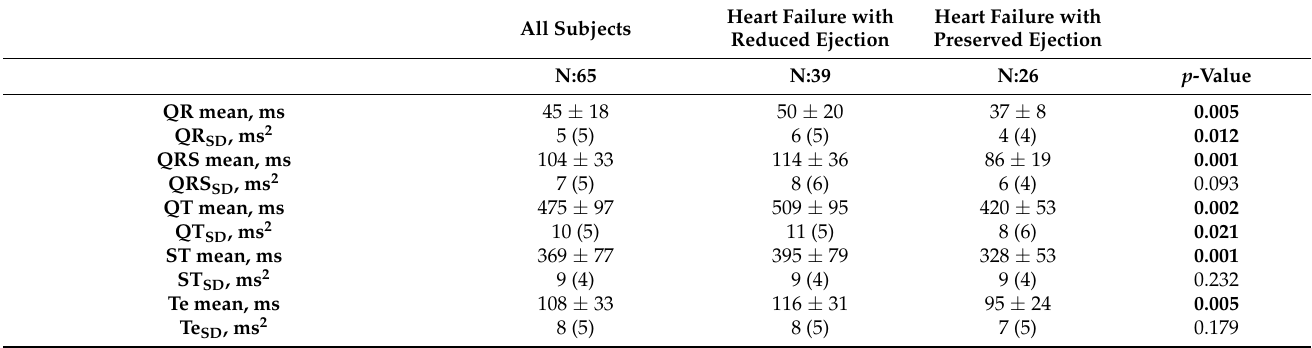
Table 3. Baseline Short-Period Repolarization Temporal Dispersion Variables in all Study Patients.